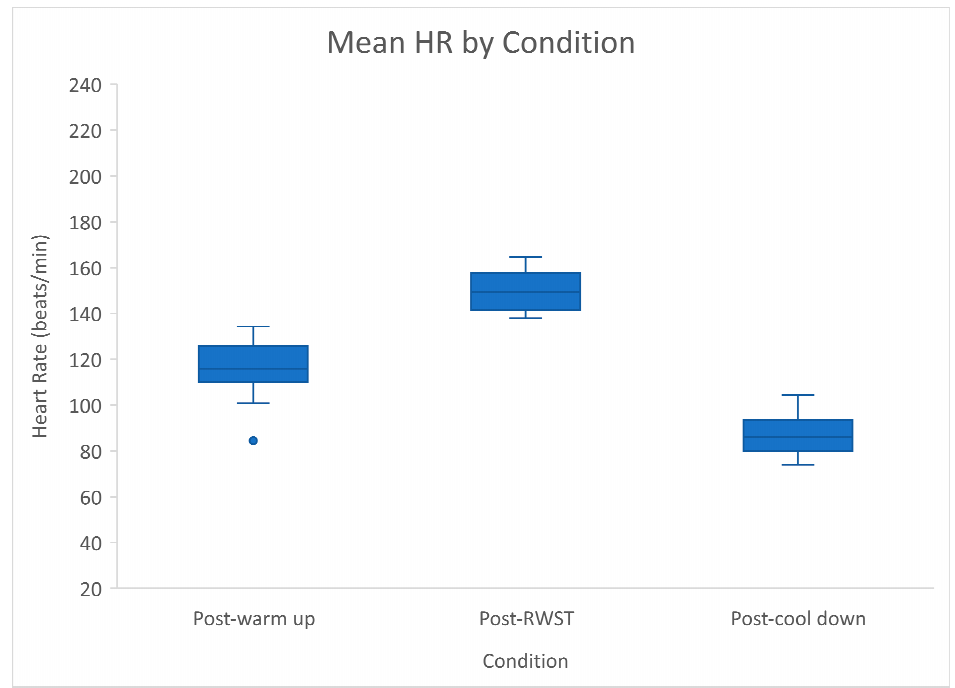
Figure 3. Mean HR by active condition—error bars represent standard deviation and isolated point represents outlier.